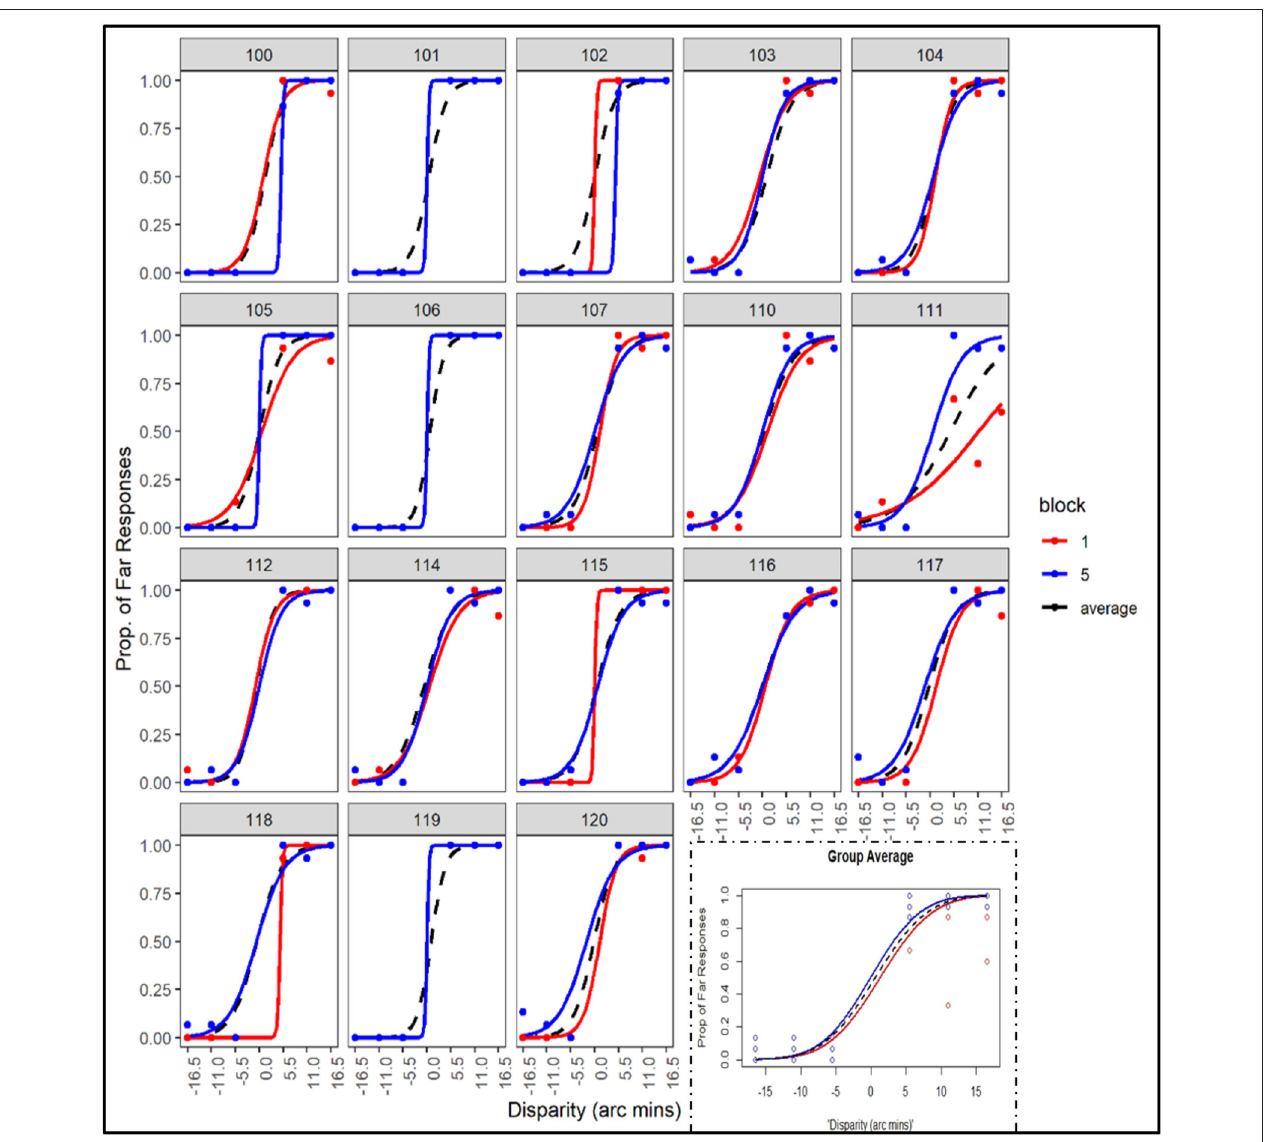
FIGURE 3 | Logistic disparity psychometric curves derived by fitting the logistic function to depth-discrimination responses across disparity values (negative and positive values correspond to crossed and uncrossed disparity, respectively) for each participant. The average curves across data of all the participants are shown as the inset in the lower right-hand corner (plotted here are data from Block 1, Block 5, and the averaged data across all five blocks from Session 2). Curves from Block 1 and Block 5 are identical for three participants and are shown only in